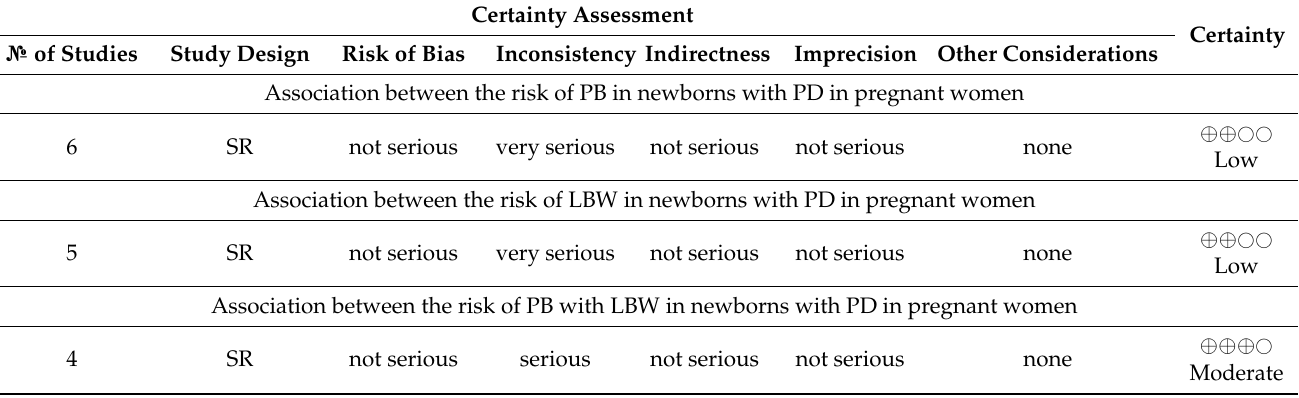
Table 5. GRADE Table 5. GRADE analysis.